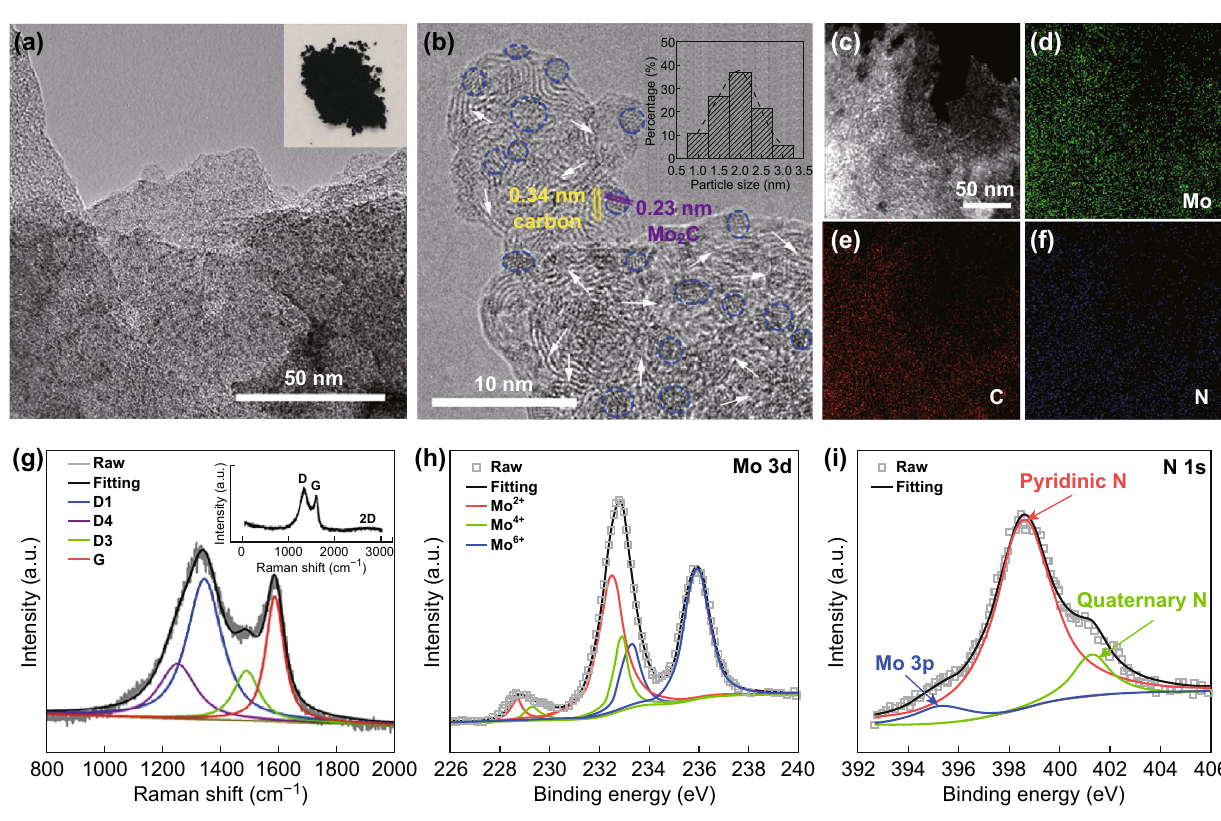
Fig. 3 a TEM and b HRTEM images of MoNCs. Inset in a shows the optical photograph of Mo 2 C; inset in b shows the size distribution of Mo 2 C. c High-angle annular dark-field scanning transmission electron microscopy (HAADF-STEM) and d–f corresponding elemental mapping images. g Curve-fitting result of the Raman spectrum and the h Mo 3d and i N 1 s XPS spectra of